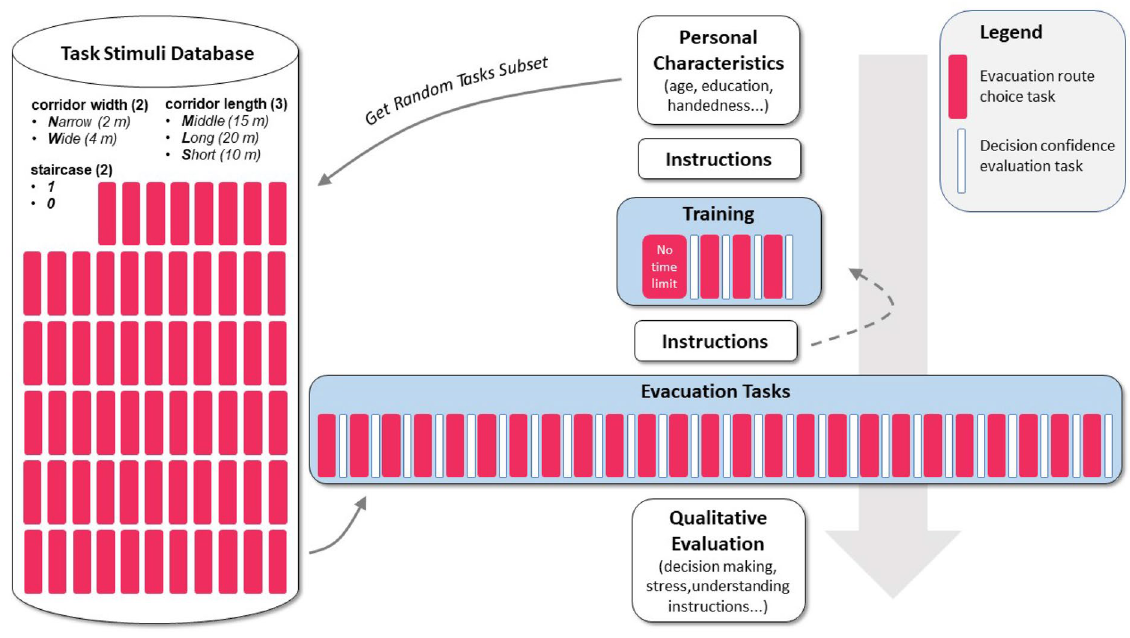
Figure 2. Experiment